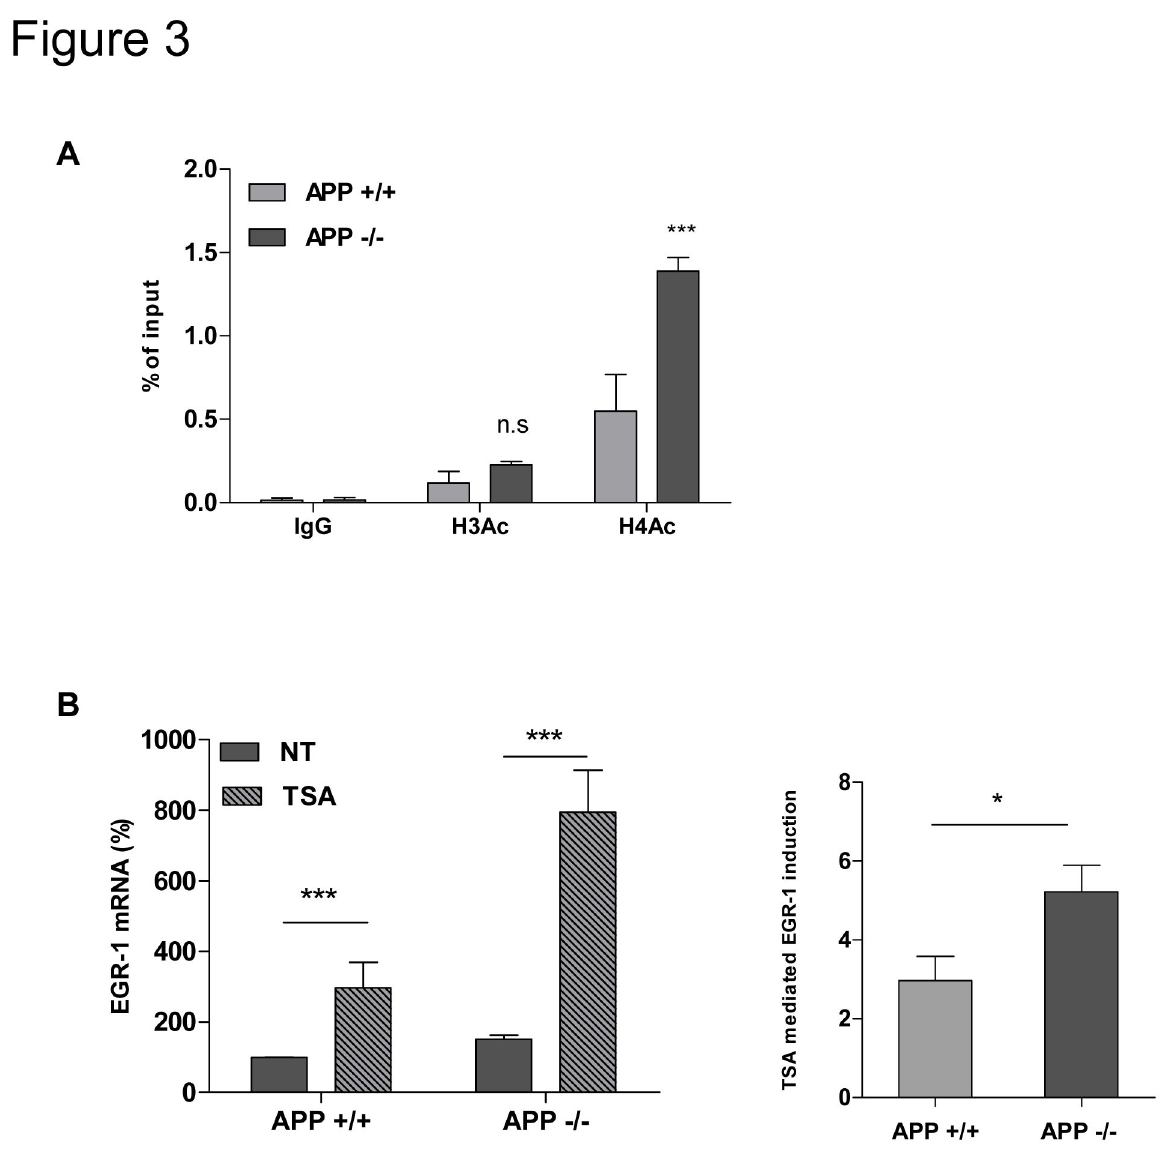
Figure 3. Epigenetic regulation of EGR-1 gene expression by APP. A . Fragmented chromatin obtain from APP+/+ and APP-/- neurons DIV5 (n=3) was immunoprecipitated with antibody recognizing normal mouse IgG as negative control (IgG), anti-acetylated histone H3 (H3Ac) or anti-acetylated histone H4 (H4Ac). Quantification was realized by real-time qPCR performed on immunoprecipitated DNA with primers designed on EGR-1 promoter, and normalized to the input. n.s. non-significant. ***p<0.001. B . EGR-1 mRNA levels were quantified in APP+/+ and APP-/- neurons DIV5 treated (TSA) or not (NT) for 24 h with 25ng/ml TSA (n=6). Values were normalized to the GAPDH mRNA, and expressed as percentage of APP+/+. Two way Anova. **p<0.005, ***p<0.001. Relative induction of Egr-1 after exposure to TSA after normalization. Student t test. *p<0.05. doi: